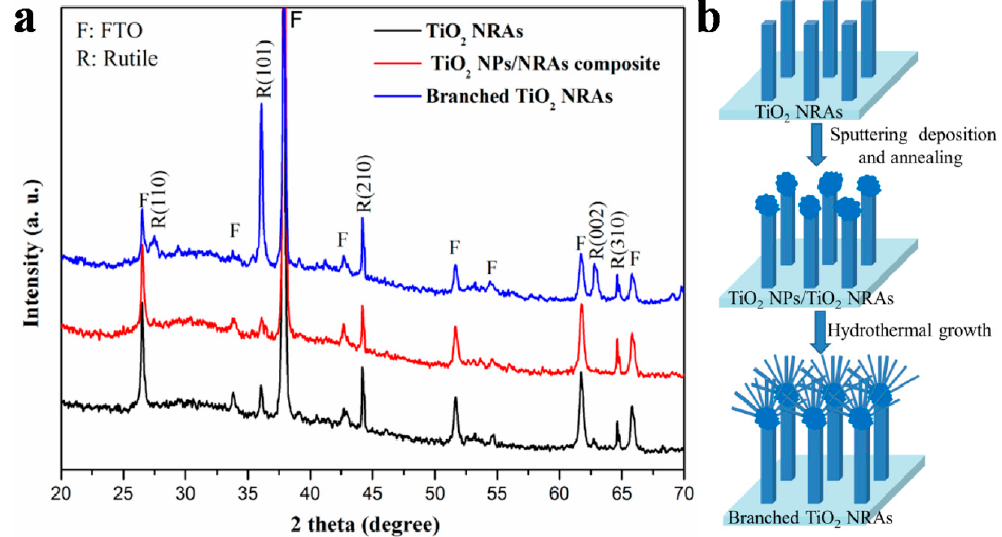
Figure 2. ( a ) XRD patterns of TiO 2 NRAs, Nps/NRAs and branched NRAs; and ( b ) schematic growth of branched TiO 2 NRAs.